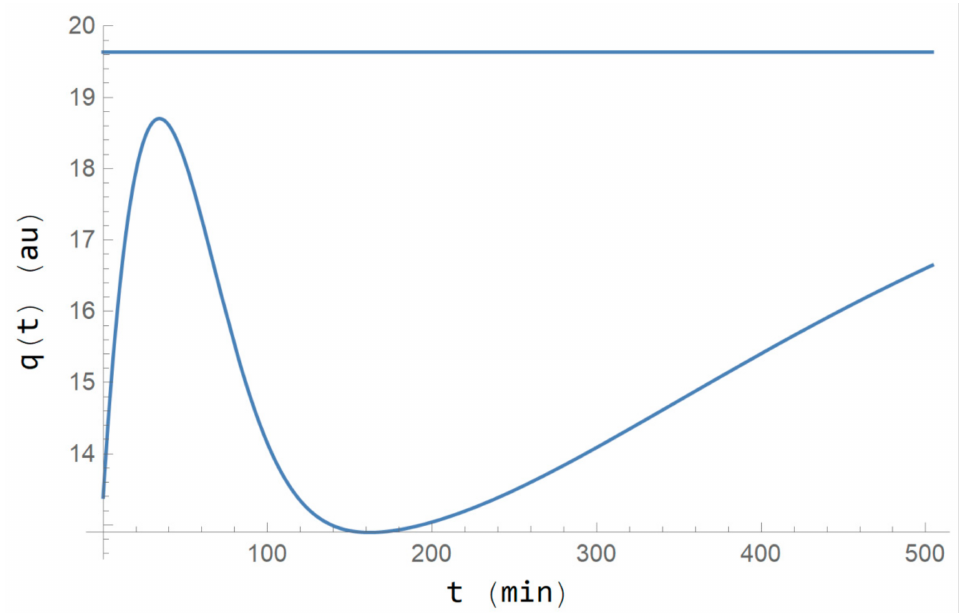
Figure 3. Evolution of the GFP or q ( t ) for the calibrated curve and the tonic level b = 19,636 au (upper line), in a period four times that of the experiment, i.e., 4 · 126